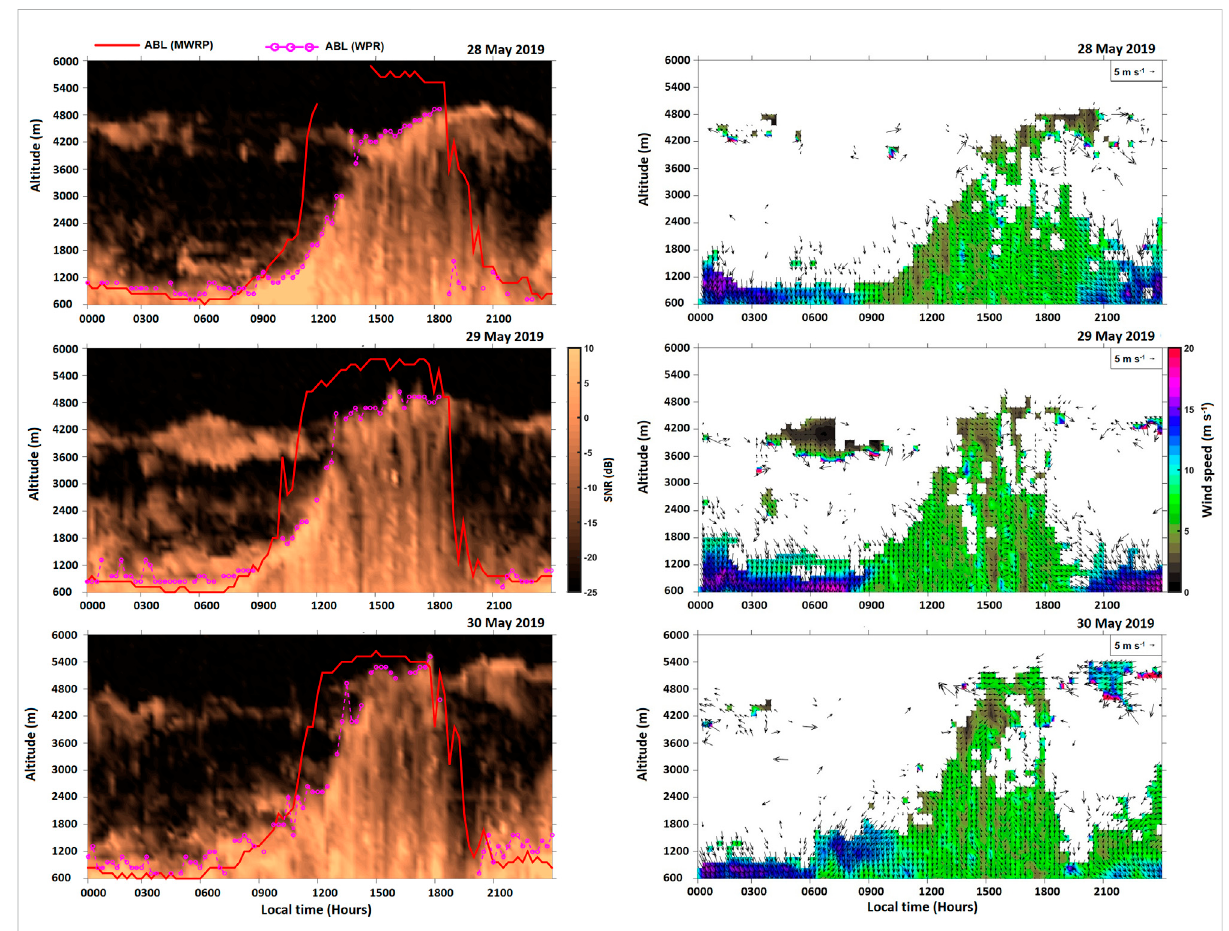
FIGURE 7 Estimated Atmospheric boundary layer height (dashed pink line) variation during 28 – 30 May 2019 estimated based upon 15-min mean SNR pro fi les (Left side panels). The adjacent panels on the right side depict the diurnal variation of the horizontal wind